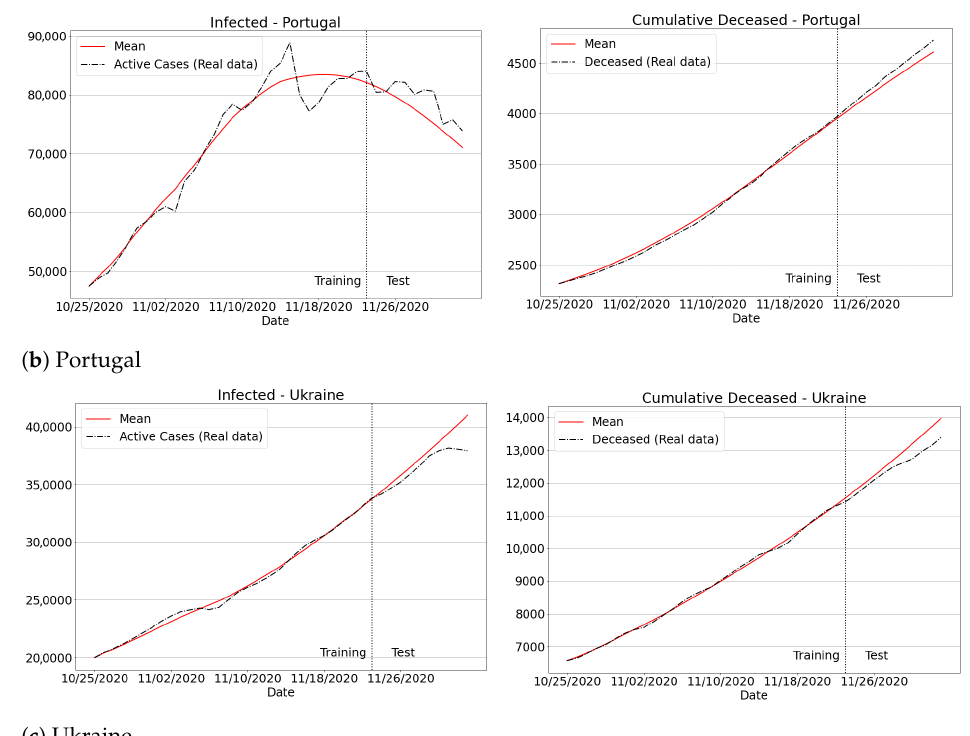
Figure 14. Infected and deaths for Italy, Portugal and Ukraine over recent